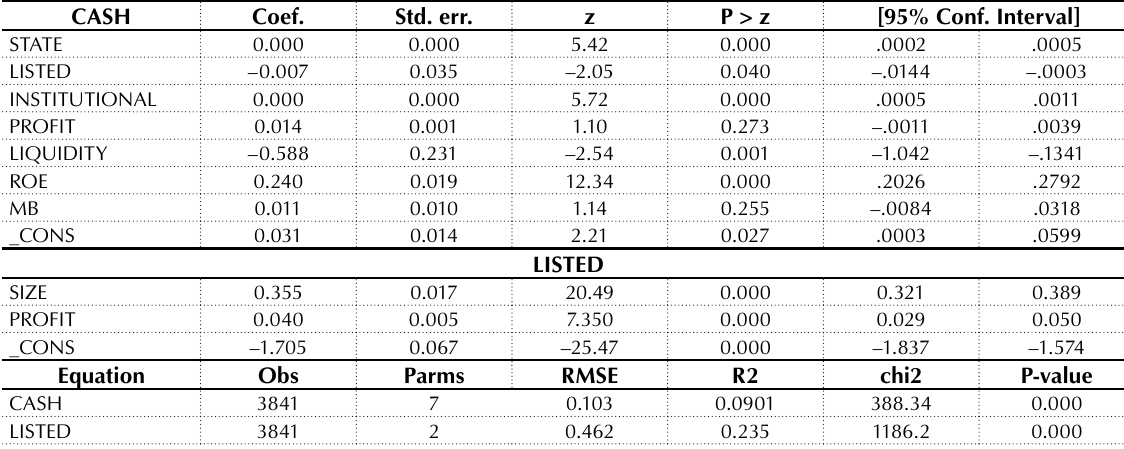
Table 4. Impact of the prestige of stock exchanges on the cash holding